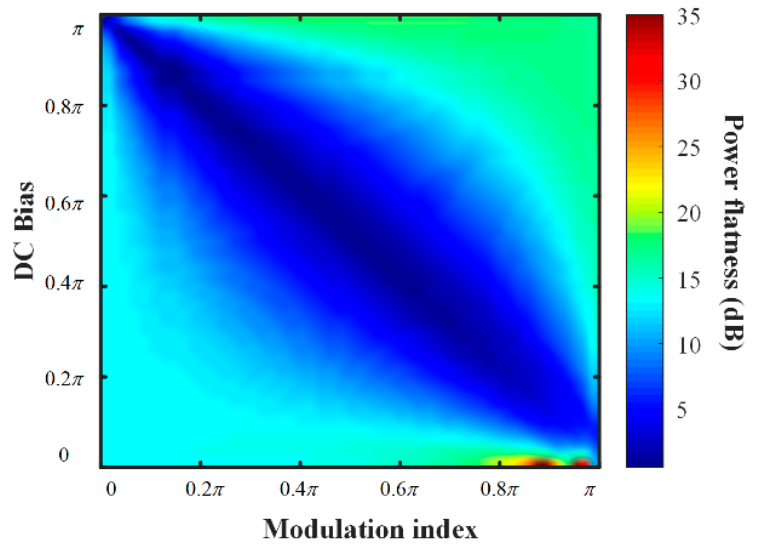
Figure 4. Simulated power flatness of the generated OFC under a different modulation index and DC bias of the MZM.